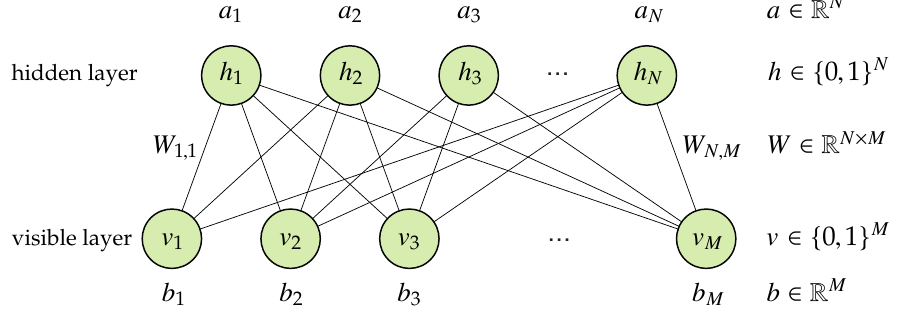
Figure 3: Original EPS image Figure 1. Structure of the